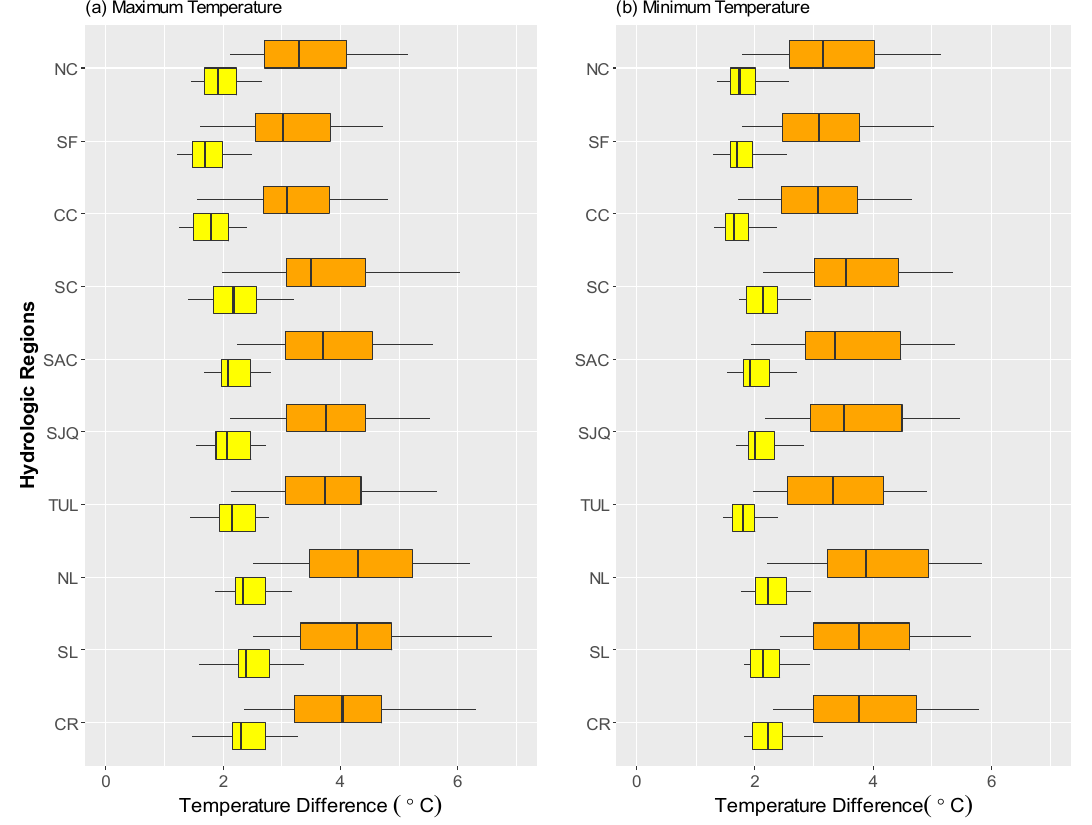
Figure 7. Box-and-whisker plots of differences (°C) between historical and individual projections on mean annual: ( a ) maximum temperature; and ( b ) minimum temperature. Yellow boxes represent mid-century results and orange boxes show late-century results.